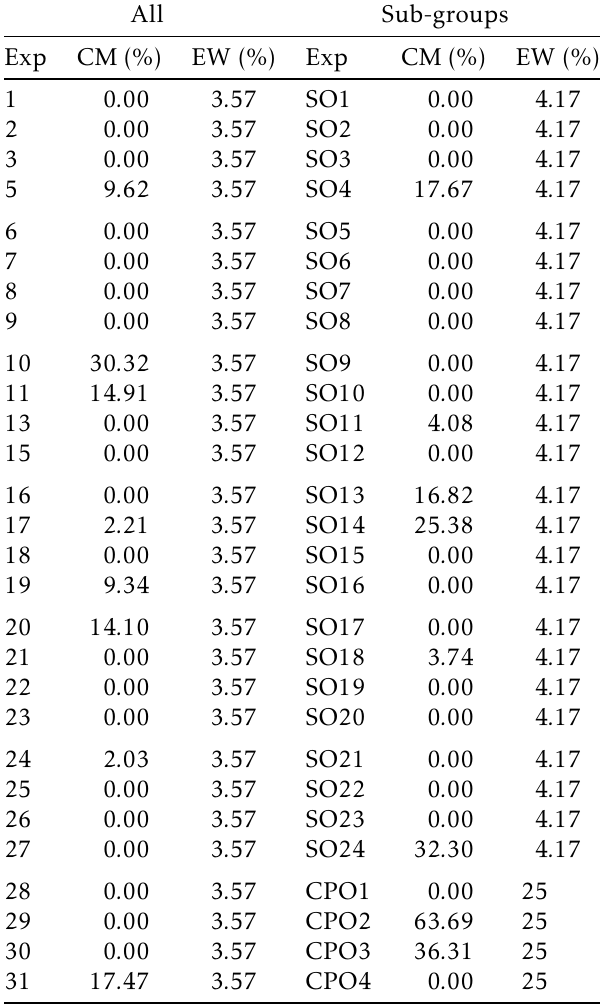
Table A1: Experts’ weights for both the Classical Model (CM) and the Equal Weight (EW) for the whole group and for the “Scientist/Observatory staff” (SO) and “Civil Pro- tection/Other” (CPO)